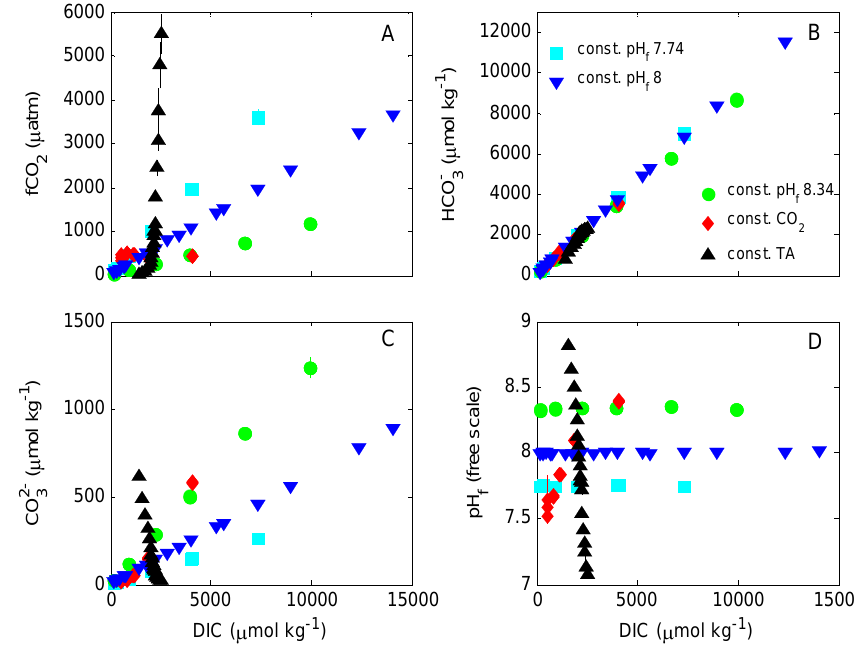
Figure 2. Carbonate chemistry speciation in relation to DIC. Error bars denote the change in carbonate chemistry from the beginning to the end of the experiment. Note that error bars are in most cases masked by symbol size. (A) fCO 2 (B) HCO 3- (C) CO 32- (D) pH f . Symbol and colour coding is shown in panel B.